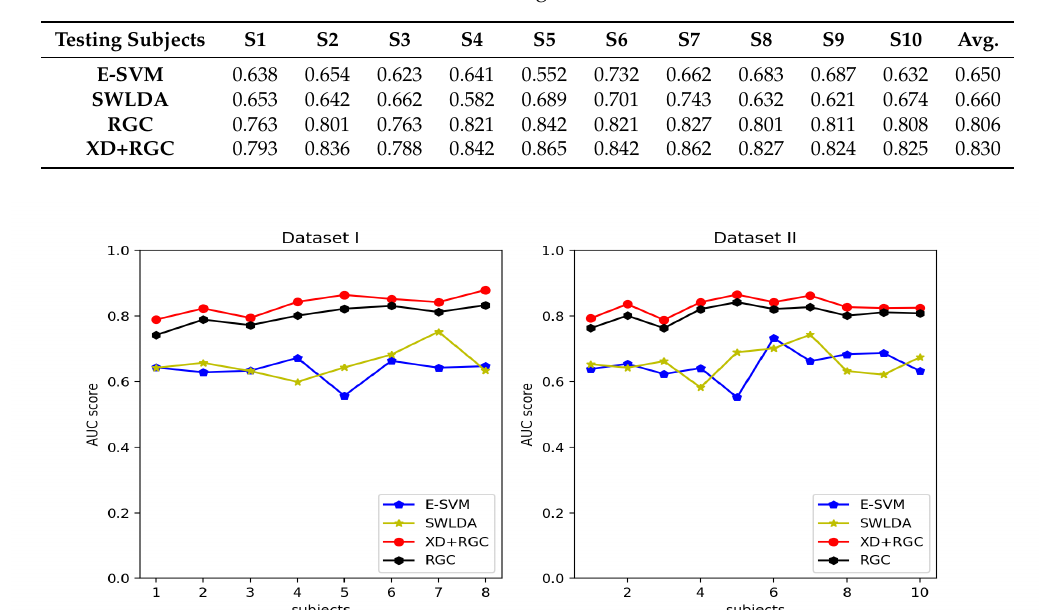
Table 6. All-to-One transfer learning AUC score results of Dataset II.